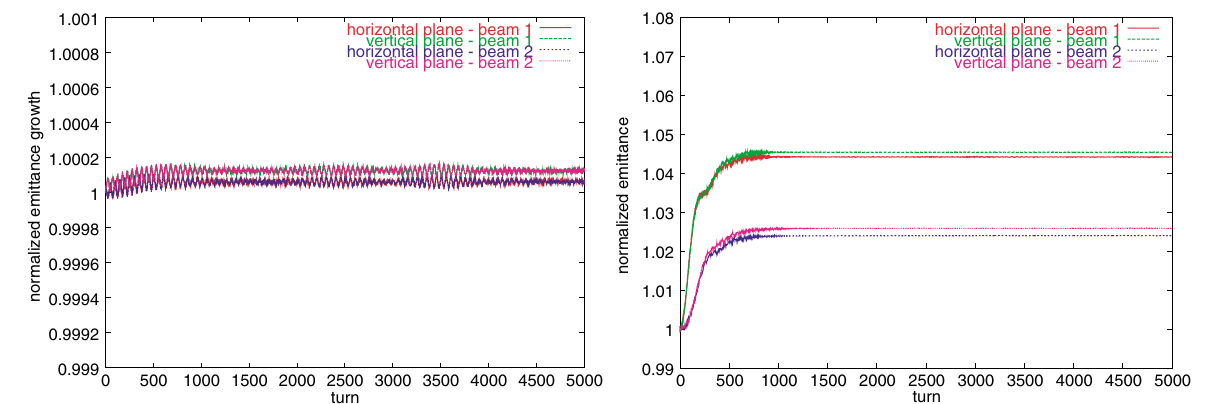
FIG. 7. (Color) The emittance evolution in the strong-strong beam-beam interaction without and with initial 20% mismatch in both planes of the first beam.